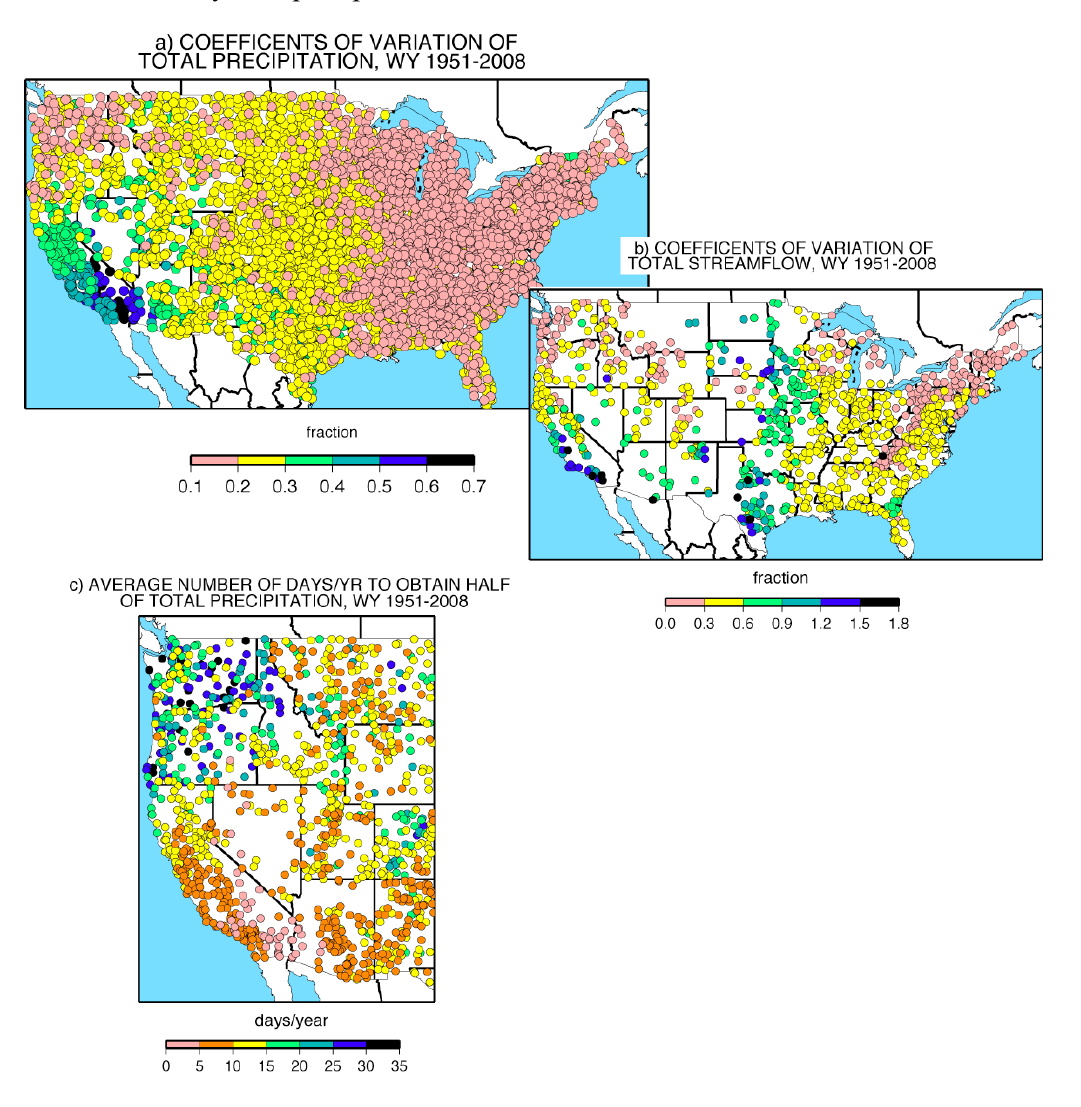
Figure 2. Coefficients of variation of water-year (a) precipitation and (b) streamflow totals at long-term monitoring stations across the conterminous US, from water year 1951–2008, along with (c) tallies of the minimum number of wet days per year, on average, that provide half of the year’s precipitation in the western